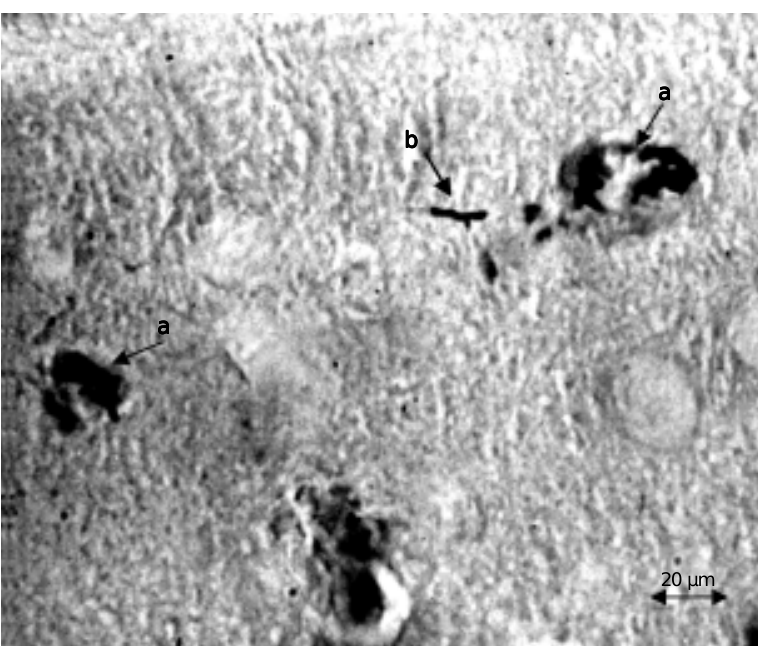
Figure 2. Micrograph of a mouse substantia nigra submitted to modified Brown and Brenn Gram staining, 24 h post-inoculation of 5 x 10 6 colony forming units of Nocardia otitidiscaviarum (GAM-5). a , Filaments from the bacteria inside the neuron perikaryon. b , Bacterial filaments in the brain parenchyma without evidence of an inflammatory re- sponse.